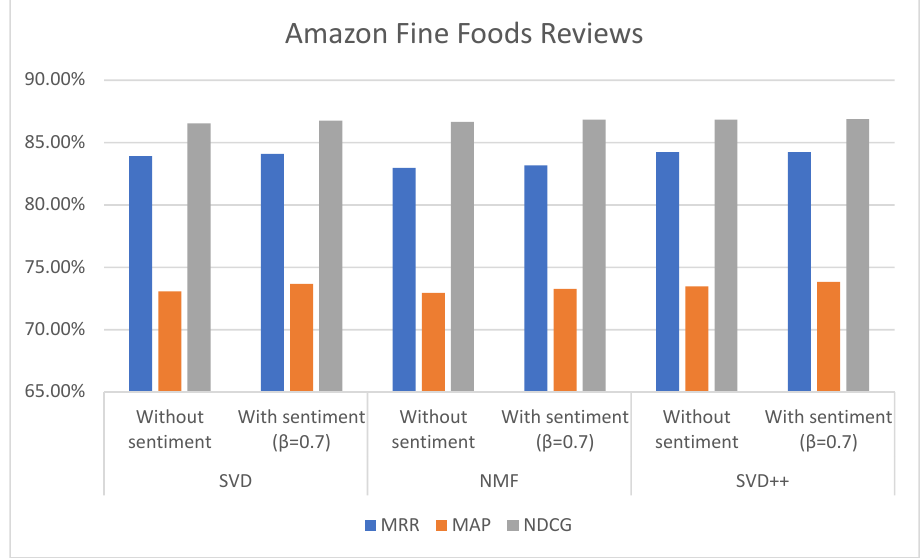
Figure 11. MRR, MAP, and NDCG values without and with L-CNN sentiment model on Amazon Fine Foods Reviews with β = 0.7. Table 7. MRR, MAP, and NDCG values without and with C-LSTM sentiment model on Amazon Fine Foods Reviews with = 0.7.